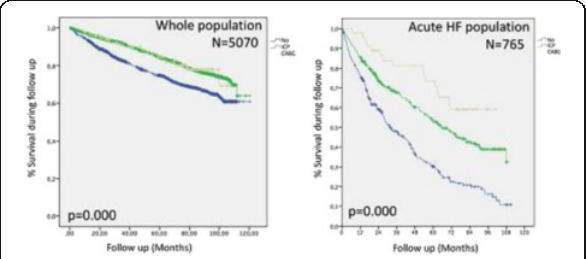
Fig. 84 (abstract A190). Prognosis impact of